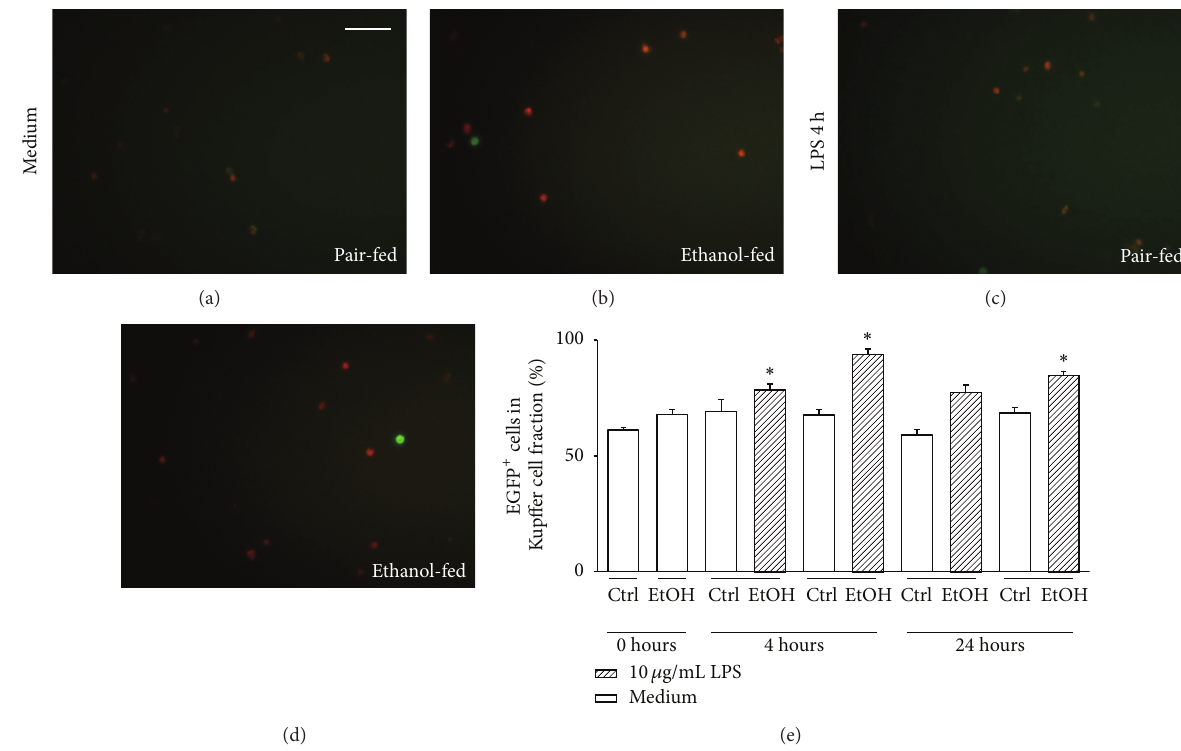
Figure 5: cis -NF- 𝜅 B EGFP transcriptional induction in F4/ 80 + hepatic macrophages at 4, 24 h after in vitro LPS challenge prior to chronic ethanol feeding. Livers of cis -NF- 𝜅 B EGFP mice were harvested 4 weeks after Lieber-DeCarli diet treatment and Kupffer cells were purified and cultured as described in Section 2. Cells were then stimulated with 10 𝜇 g/mL LPS over a period of 24 hours. Red fluorescence (F4/80) labels Kupffer cells and green fluorescence of EGFP identifies cells expressing NF- 𝜅 B transcriptional activity at 4, 24 h after LPS stimulation. (a) and (b) show representative unstimulated controls whereas in (c) and (d) representative overlay images at 4h after LPS stimulation are given (magnification, × 200). Colabeled (yellow) cells and F4/80 positive (red) cells were counted. The percentage of F4/80 + EGFP + cells in total F4/80 + cells is depicted in (e) at 4, and 24 h after LPS stimulation. Data shown are representative of five to eight separate experiments and are presented as mean ± SEM. ∗ 𝑃 < 0.05 versus